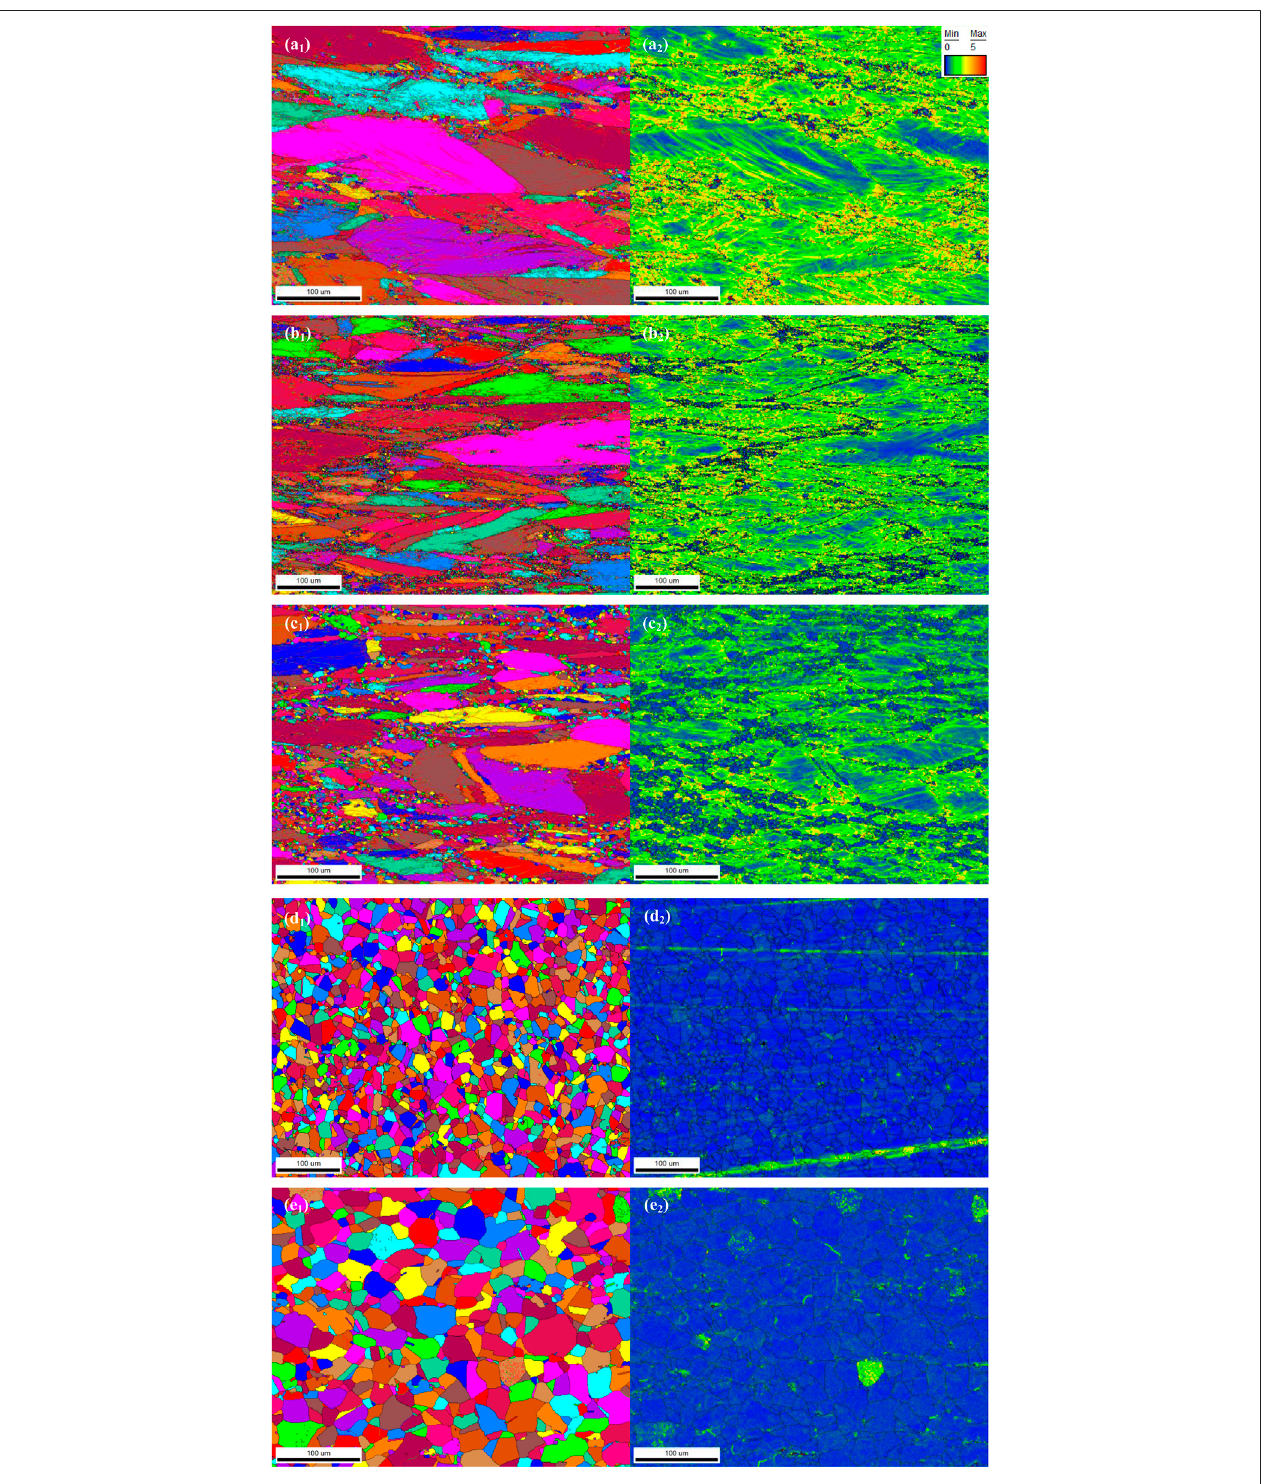
FIGURE3| TypicalOIMandKAMmapsoftheCo – Ni – Cr – W – basedsuperalloydeformedtoatruestrainof0.7 atdifferenttemperatureswithastrainrateof0.1 s − 1 : (A) 1,000 ° C, (B) 1,050 ° C, (C) 1,100 ° C, (D) 1,150 ° C, and (E) 1,200 ° C.